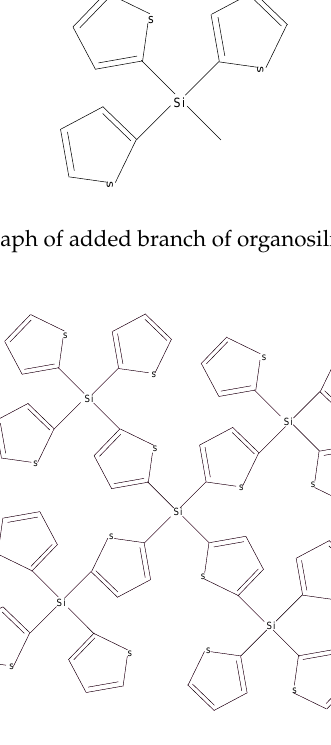
Figure 7. The graph of organosilicon dendrimer G [ 2